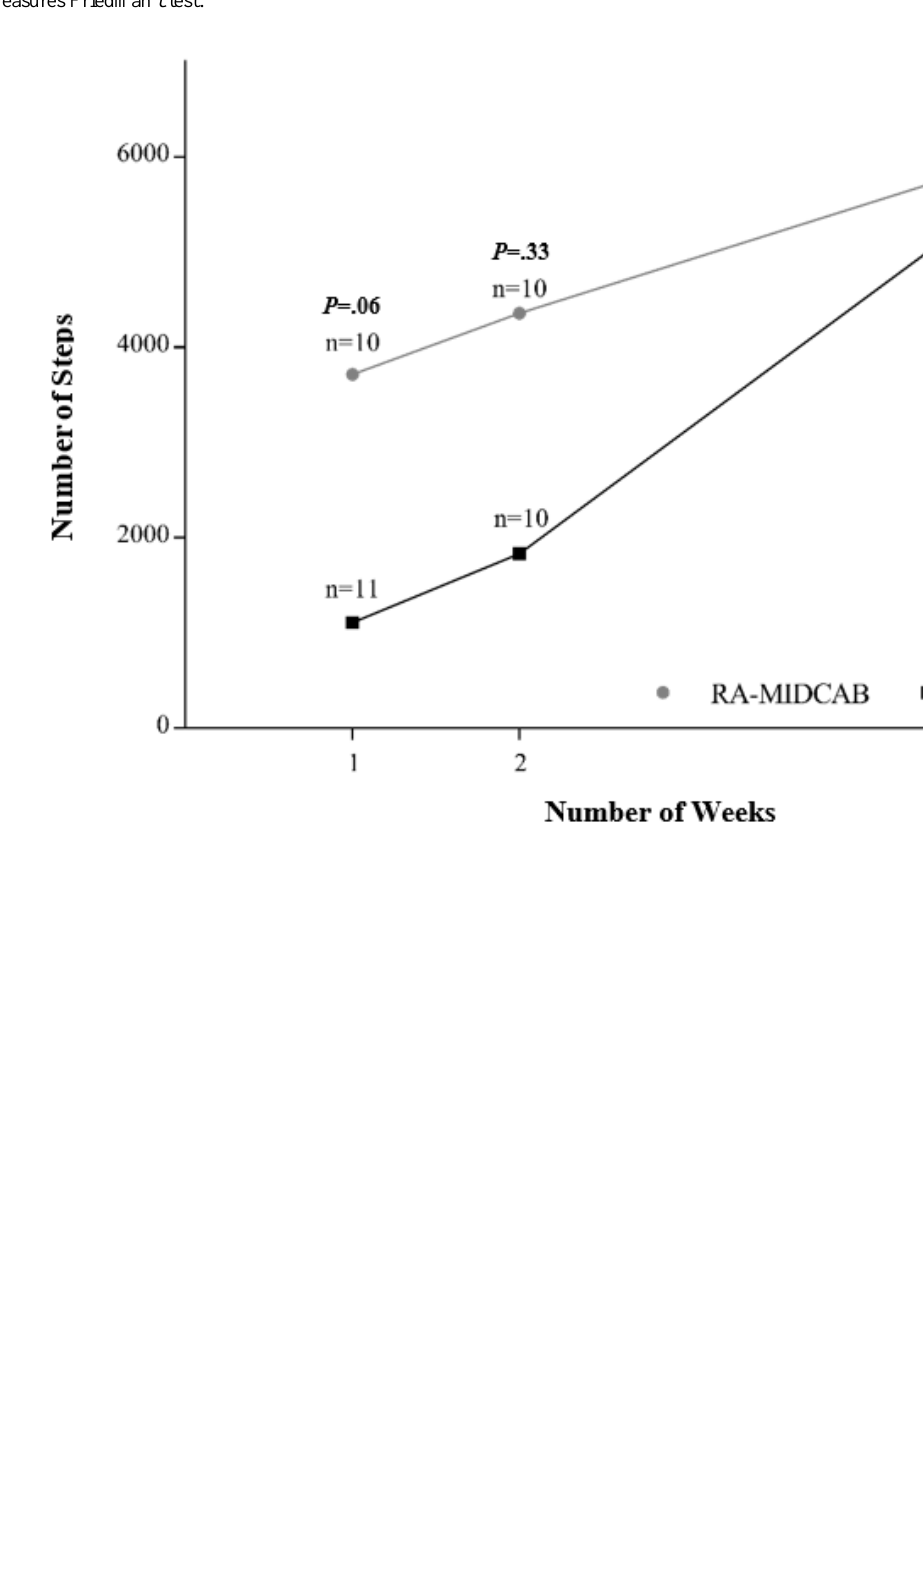
Figure 3. Weekly average number of steps in robotically assisted minimally invasive direct coronary artery bypass (RA-MIDCAB) and off-pump coronary artery bypass (OPCAB) patients plotted over time. Weekly average step count is plotted as median over time. n indicates the number of patients included in the cohort result. P value is for the Mann Whitney U test for the difference between the two groups at that time point. Χ 2 results of repeated measures Friedman t